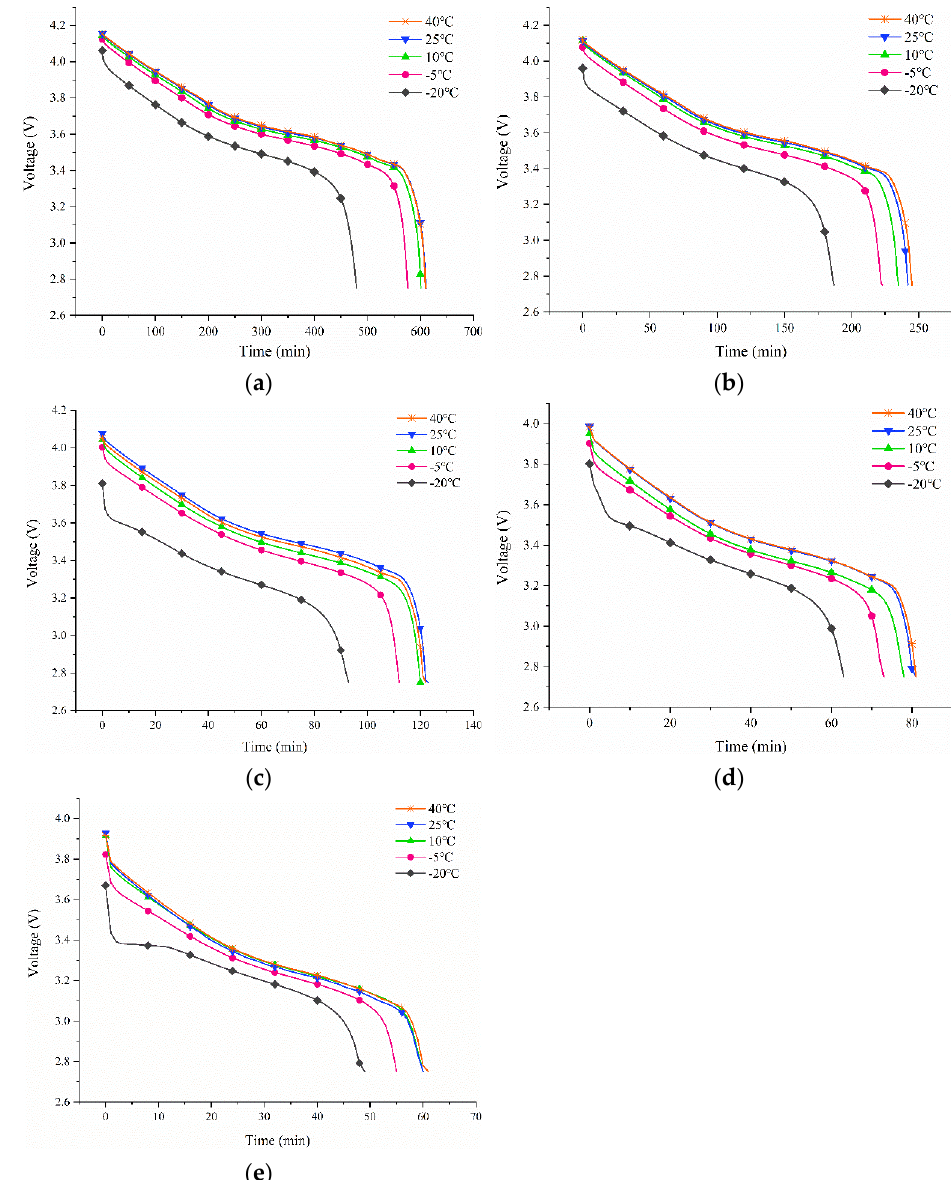
Figure 4. Discharge voltage change curve: ( a ) 0.1C discharge rate; ( b ) 0.25C discharge rate; ( c ) 0.5C discharge rate; ( d ) 0.75C discharge rate; ( e ) 1C discharge